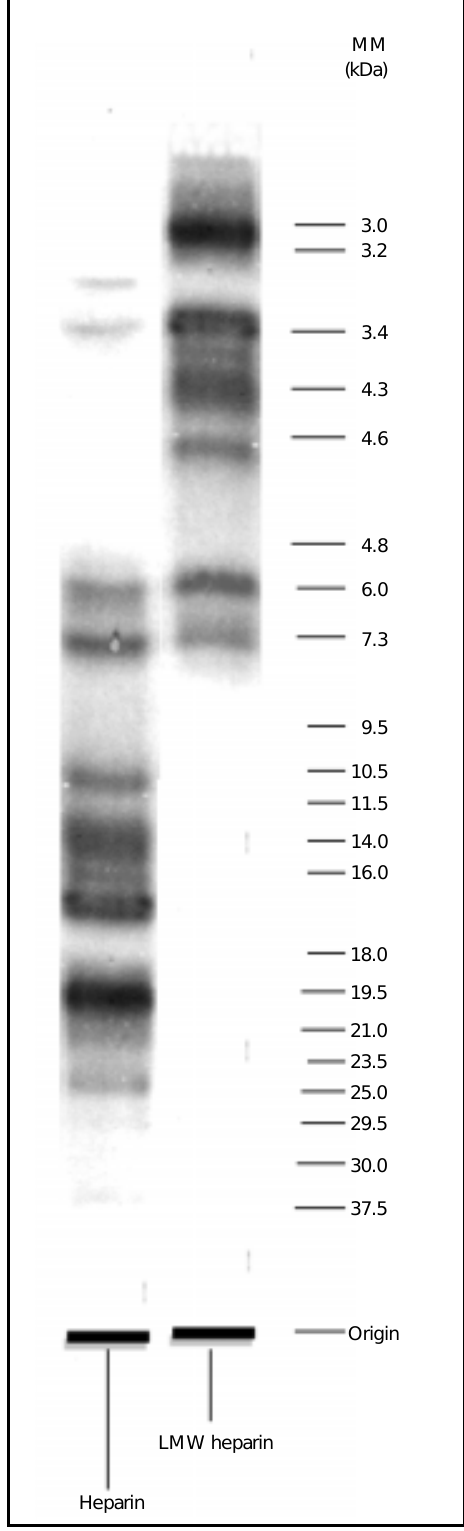
Figure 5. Electrofocusing of hep- arin and low molecular weight (LMW) heparin prepared by the Fenton reaction. The molecular masses (MM) of standards are given in kDa on the right side of the